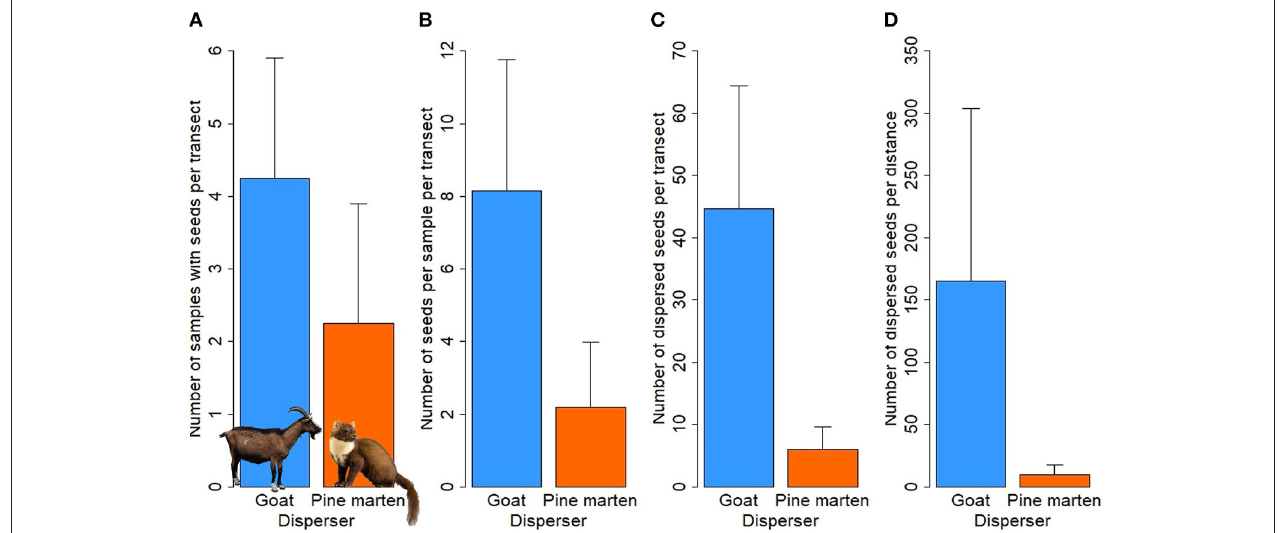
FIGURE 4 | Means ( ± SE) among the four transects of different quantitative variables for the two dispersers, goat (blue bars) and pine marten (orange bars). (A) number of samples with seeds per transect; (B) number of seeds per sample per transect; (C) number of dispersed seeds per transect; (D) number of dispersed seeds per transect corrected by distance (km).